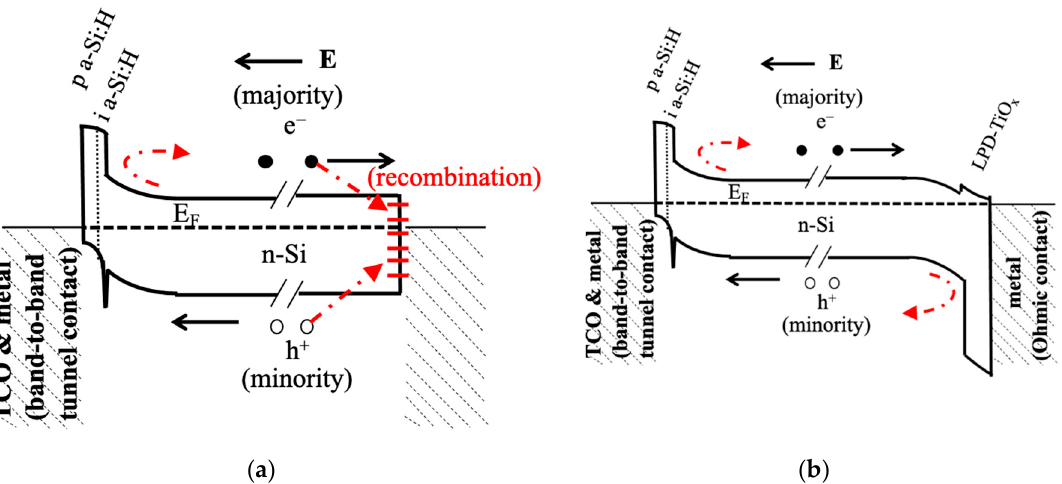
Figure 5. The schematic band alignment for the Si heterojunction solar cell ( a ) without and ( b ) with a chemically grown TiO x rear contact layer. The electron- and hole- blocking were plotted.